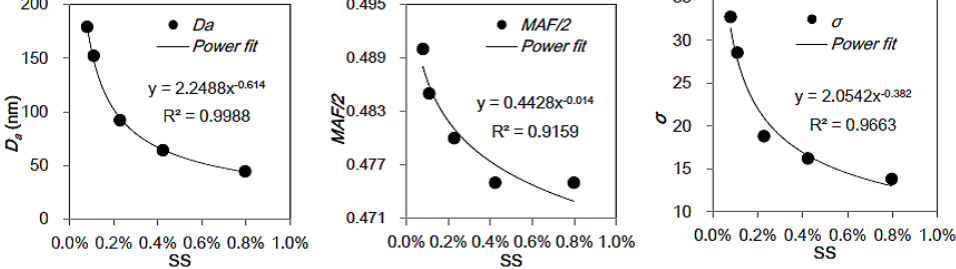
Figure 7. Activation diameter, D a , maximum activated fraction, MAF, and standard deviation, σ , as a function of super saturation,